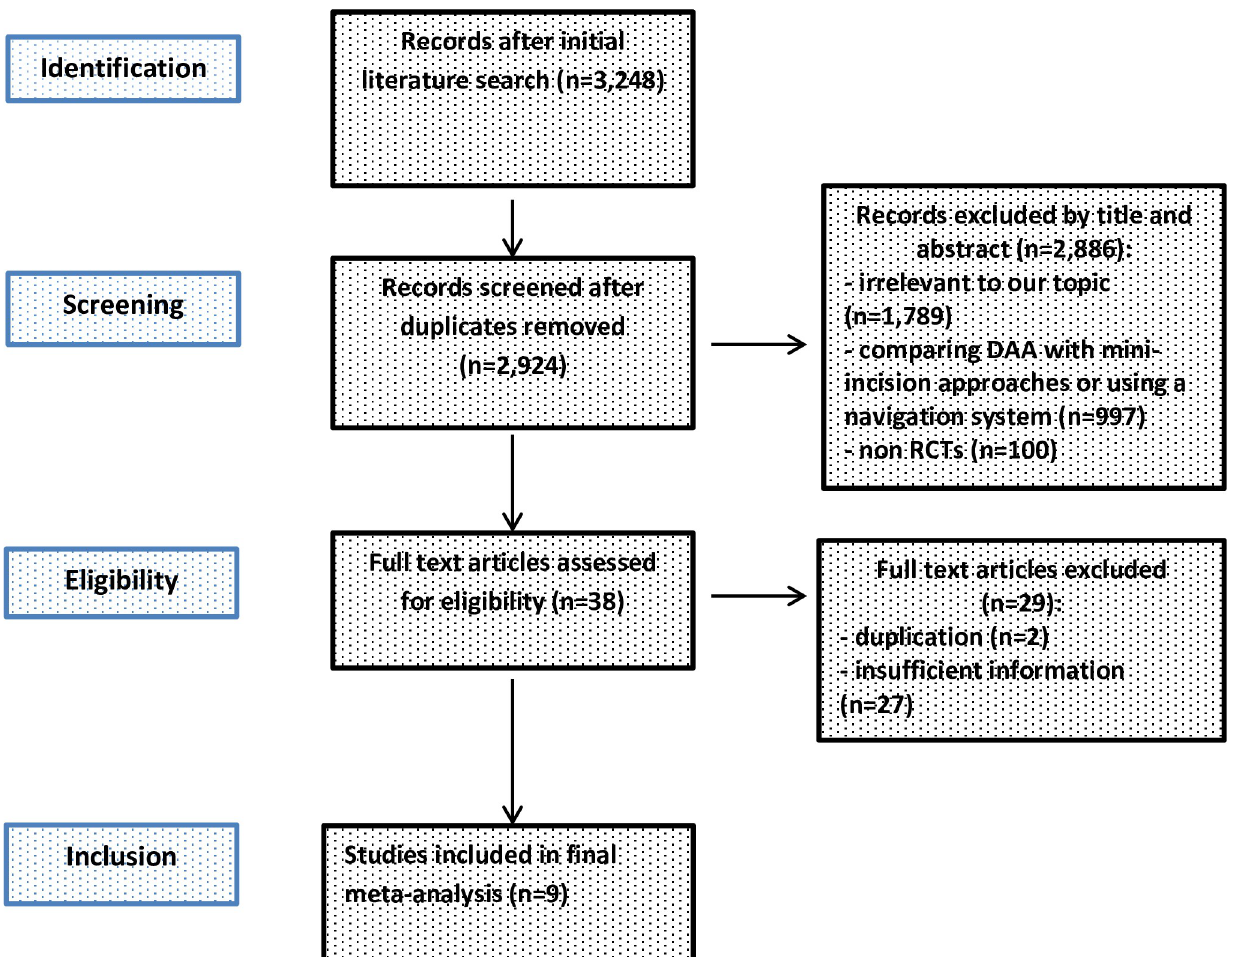
Fig 1. PRISMA flow diagram of the search results and selection according to our inclusion criteria. DAA, direct anterior approach; RCTs, randomized controlled trials.